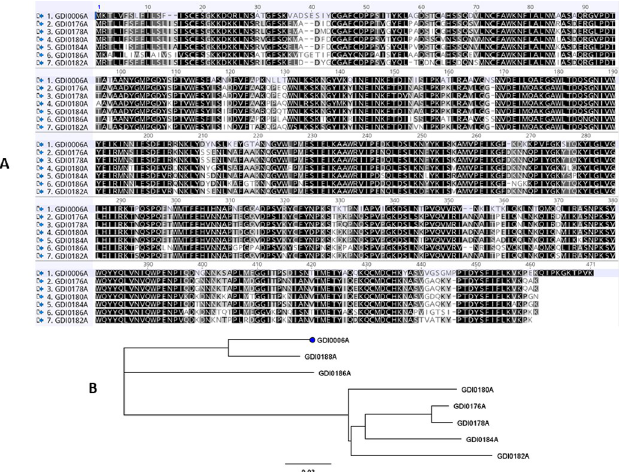
Fig 5. Protein alignment of GDI0006A homologs. (A) GDI0006A and homologous protein sequences were aligned using Geneious Multiple alignment tool with the Blosum 62 cost matrix. Identical amino acids are indicated in black; conserved amino acids in grey; all the others are in white. (B) Phylogenetic tree of GDI0006A homologs built with the Neighbor-joining method using the Jukes-Cantor Genetic Distance model (Geneious Tree Builder from Geneious).